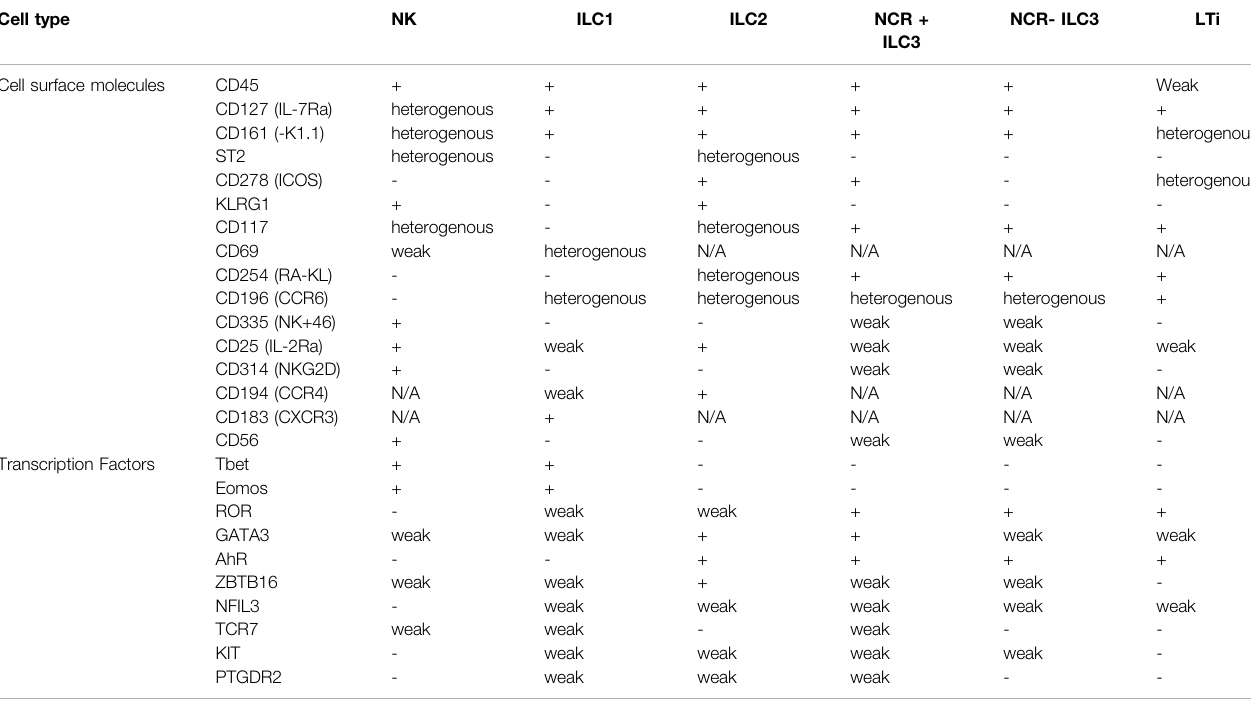
TABLE 1 | Cell surface molecules and transcription factors present on each type of ILCs. Cell